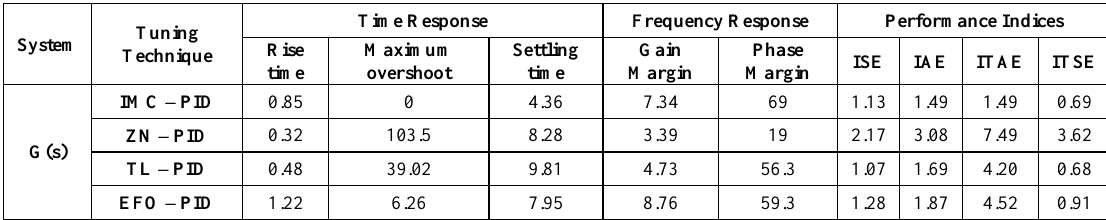
Table 7. Closed loop PID - controlled responses of G(s)